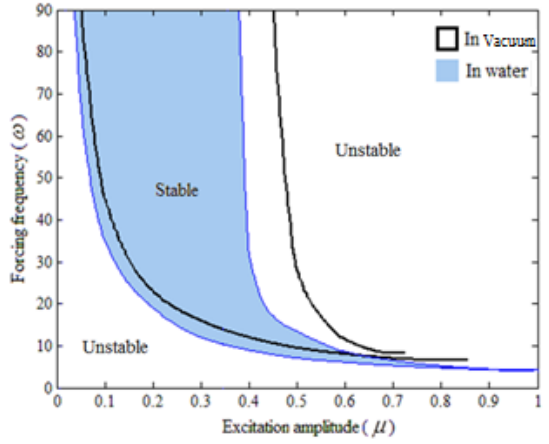
Figure 5. Combined stability regions for inverted pendulum systems.